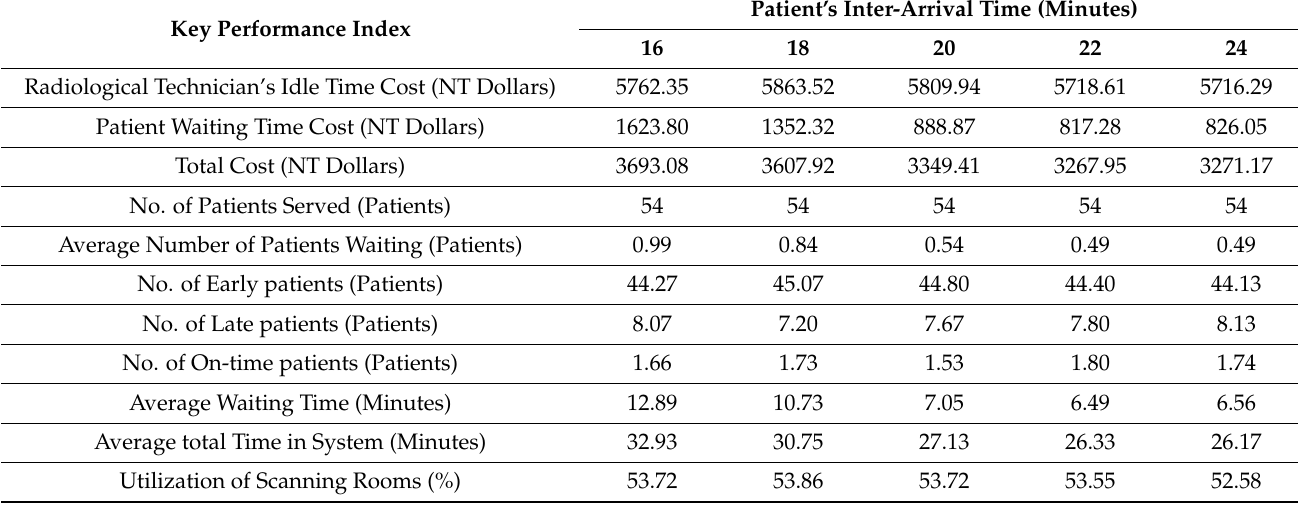
Table 13. Base-parameter analysis with the pair cost coefficients (0.5,